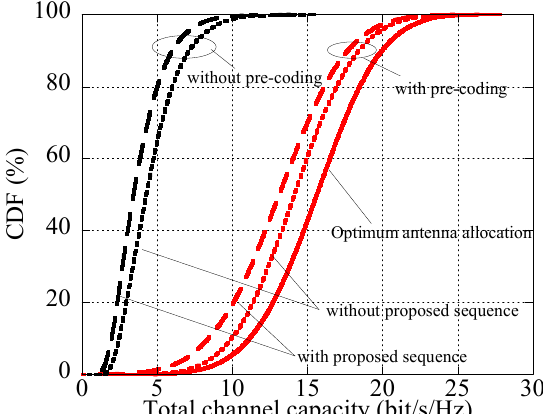
Figure 9. CDF of total channel capacities of the downlink MU-MIMO-OFDM transmission with/without the proposed pre-coding.